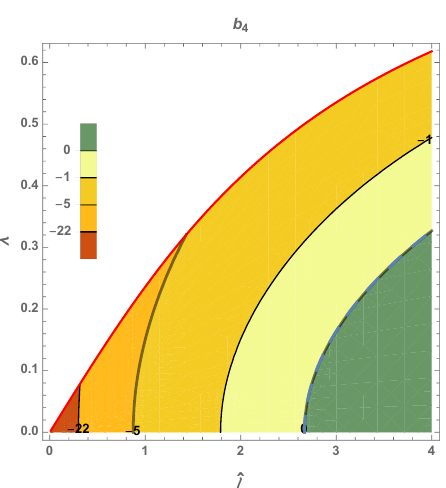
Figure 2 . The eigenvalue b 4 as a function of λ and ˆ ‘ . Here, the classically allowed region in the parameter space is divided by a critical curve (dashed line) along which b 4 = 0 . This curve is given by the equality in eq. (3.32). The area on the left of this contour is where instability occurs since b 4 is always negative. On the right of the dashed line (denoted by green colour) b 4 is always